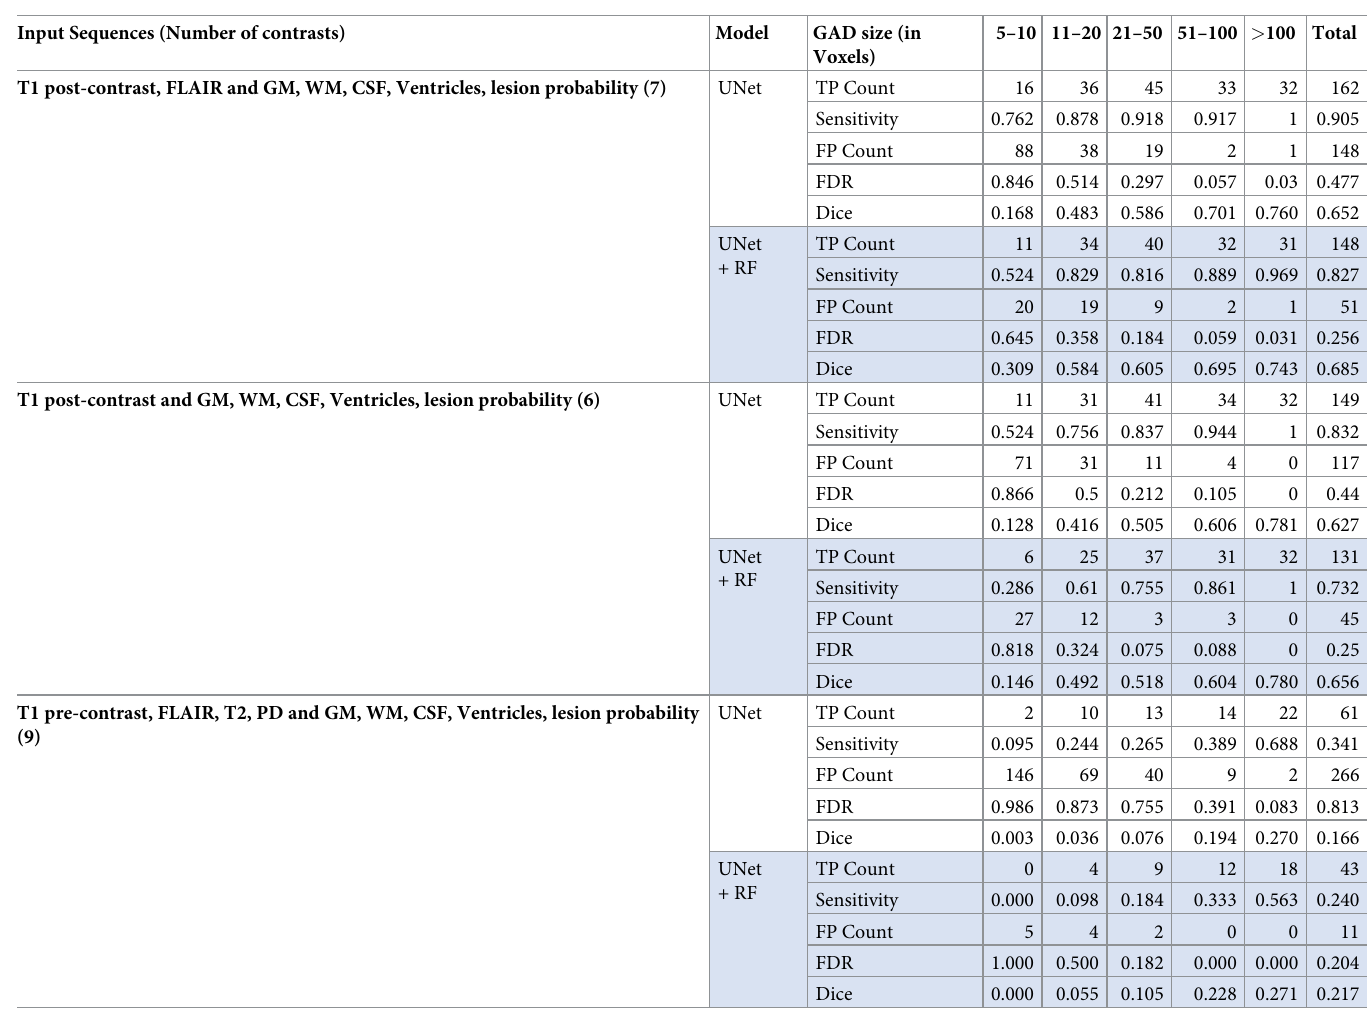
lesion detection where T1 pre-contrast, T1 post-contrast and FLAIR are most influential to detect. Fig 3e shows a lesion which cannot be detected without T2. For Dataset B with lesion count data, the model with bootstrapping cross entropy for three contrasts (T1 post-contrast, T1 pre-contrast, and FLAIR), five probability maps, and the ran- dom forest classifier, was used. The automatically segmented gadolinium-enhancing lesions were counted for each image and categorized into count groups. The lesion categorization is shown in Table 5, where TP and accuracy are presented as a confusion matrix. The overall accuracy for classification was 87.7%. S5 and S6 Tables show the model performance for different magnetic fields (1, 1.5, and 3T) and scanner vendors (Siemens and Philips), respectively. The overall accuracy for the 3T scans was the highest. The percentage of false negatives for the groups with enhancing lesions (1 lesion count group and � 2 lesion count group) were lower in 1.5T scans